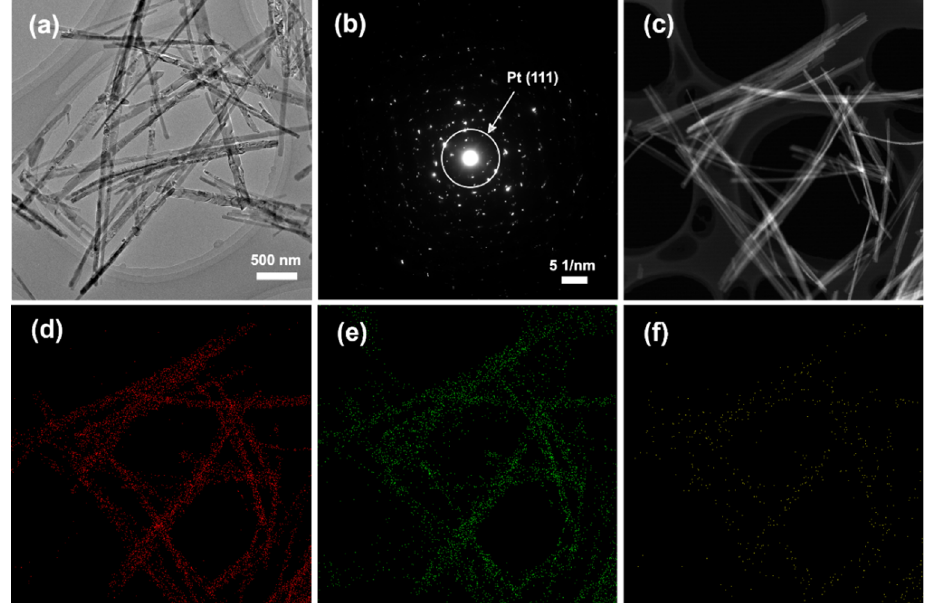
Figure 4. TEM image of Pt deposited TiO 2 MP ( a ) and the corresponding SAED patterns ( b ); STEM image of Pt deposited TiO 2 MP ( c ), and the corresponding EDX mapping images of elemental Ti ( d ), O ( e ), and Pt ( f ).